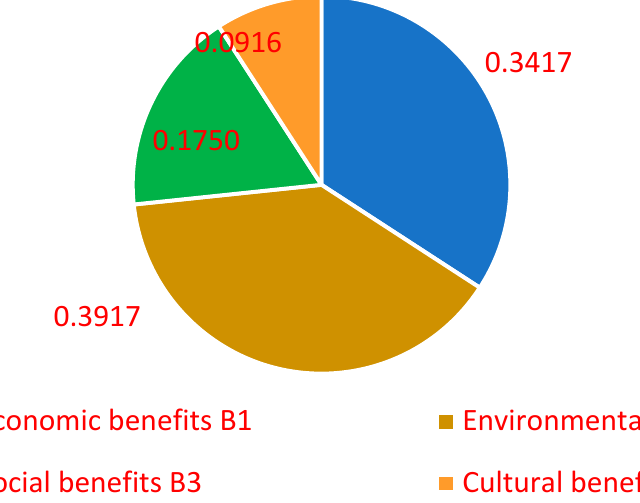
Figure 2. The weighting diagram of the criterion layer indicators.